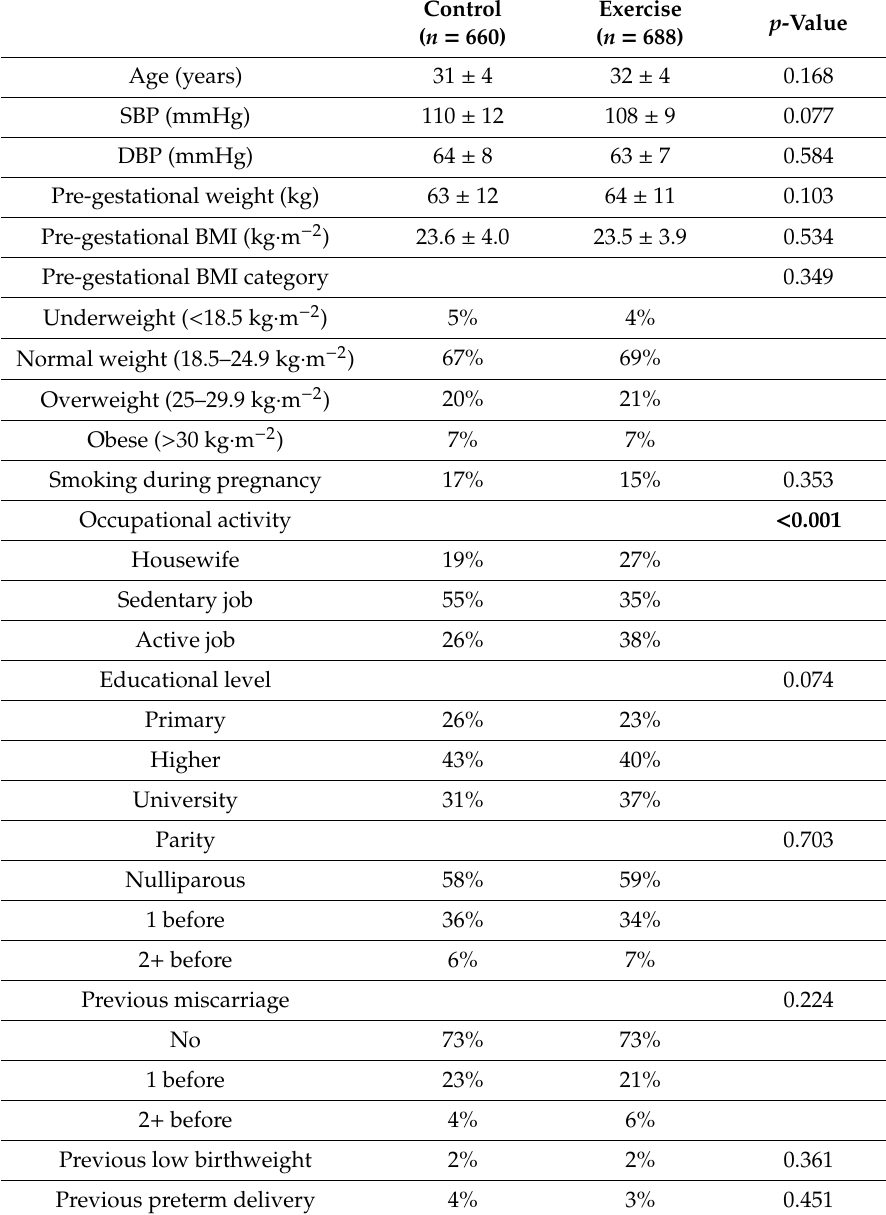
Table 1. Participants’ baseline characteristics in the intervention (exercise) and control